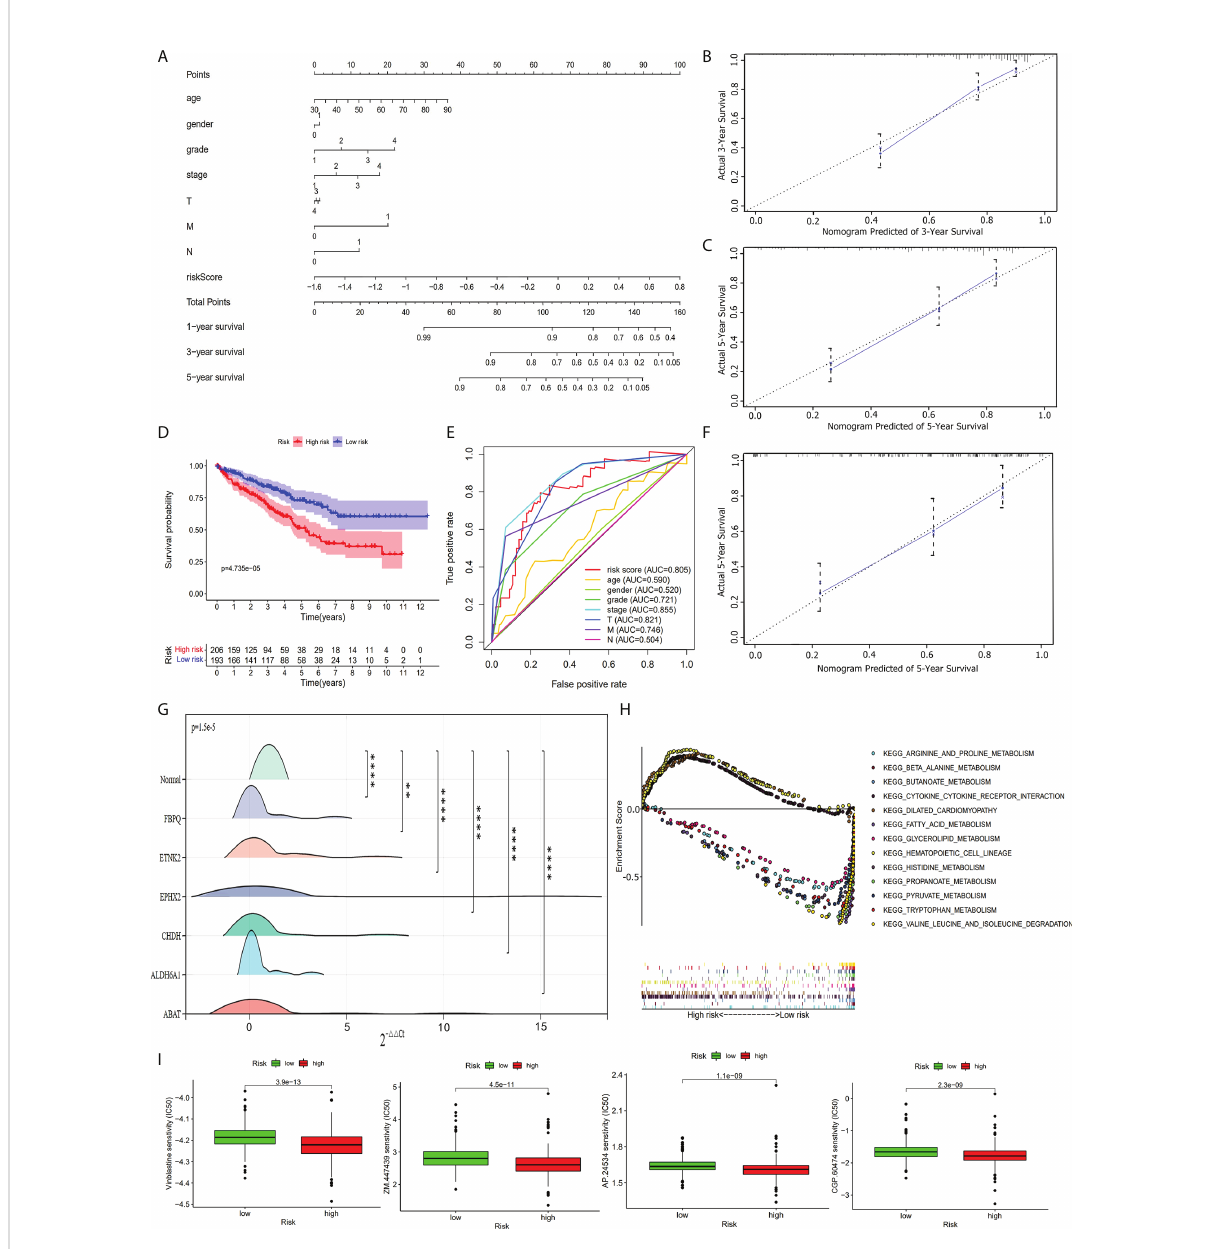
FIGURE 8 Further analysis of the prognostic model. (A) The prognostic nomogram for the prediction of 1- to 5-year overall survival in ccRCC. (B) The calibration curves of the nomogram for the prediction of 3-year survival. (C) The calibration curves of the nomogram for the prediction of 5- year survival. (D) Kaplan-Meier survival curve for high-risk and low-risk patients in the validation cohort. (E) ROC curve in the validation cohort. (F) The calibration curves of the nomogram for the prediction of 5-year survival in the validation cohort. (G) RT-qPCR validation shows the expression of the six hub genes was downregulated in ccRCC tumor tissues. **, P< 0.01; ****, P< 0.0001. (H) Multi-GSEA enrichment analysis shows the top 13 representative KEGG pathways in high-risk and low-risk patients. (I) Drug sensitivity analysis shows the most sensitive four drugs in high-risk